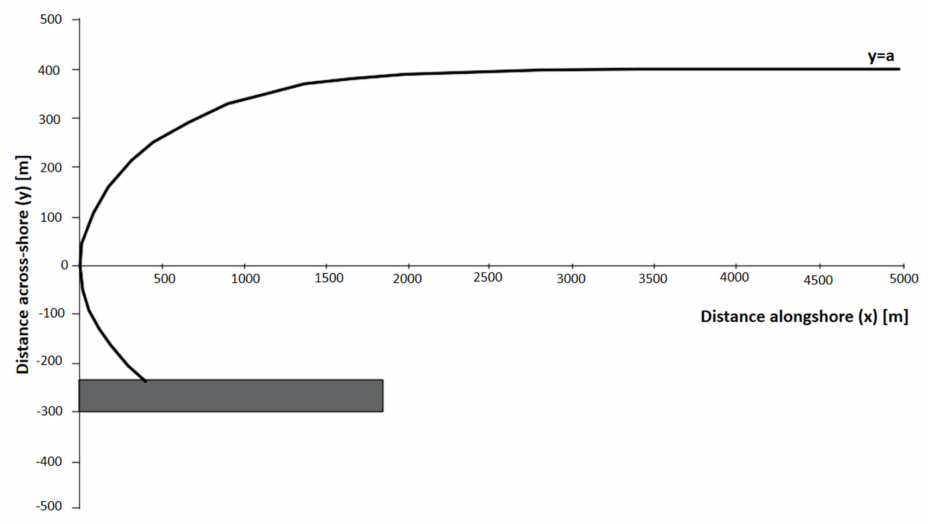
Figure 3. Definition sketch for the hyperbolic-tangent shape equation. The x-axis is parallel to the general trend of the shoreline while the y-axis points shoreward; the origin of the coordinates is placed at the point where the local tangent to the beach is perpendicular to the general trend of the shoreline. The hyperbolic tangent curve is symmetric with the x-axis and produces two asymptotes, found at y = ± a . The line y = + a indicates the location on the shoreline which is no longer under the influence of the headland. The parameter a controls the magnitude of the asymptote (distance between the relative origin of coordinates and the location of the straight shoreline), b is a scaling factor controlling the approach to the asymptotic limit and m controls the curvature of the shape. These unknowns were found by using trial and error and an optimisation procedure that minimises rms errors. The authors of [13] found the following relationships: ab ∼ = 1.2; m ∼ =